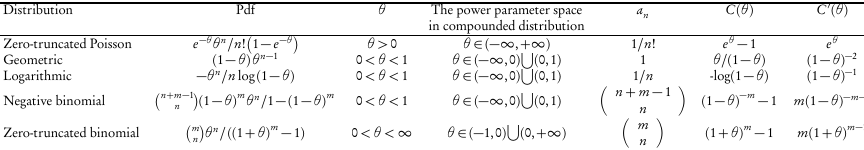
Members of the power series